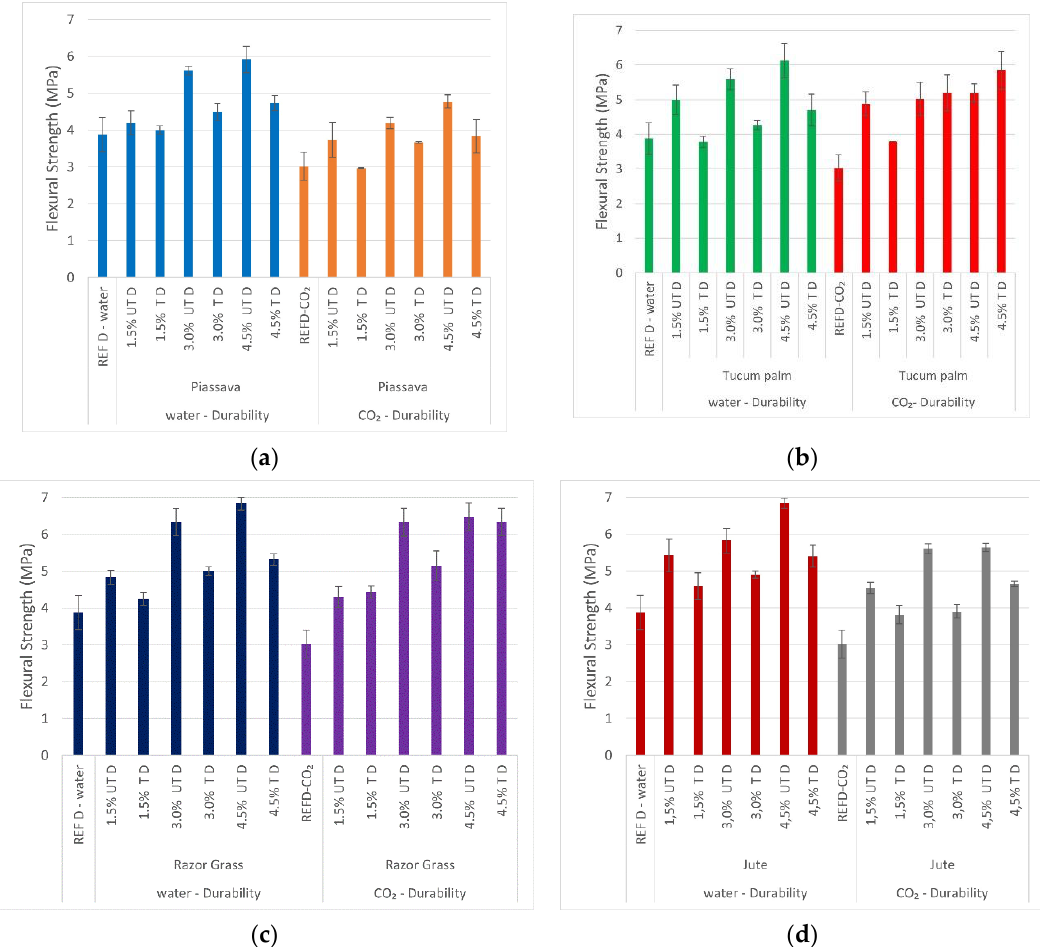
Figure 12. Durability cycles — flexural strength mortars: ( a ) 1.5%; 3.0%; 4.5% piassava mortars; ( b ) 1.5%; 3.0%; 4.5% tucum palm mortars; ( c ) 1.5%; 3.0%; 4.5% razor grass mortars; ( d ) 1.5%; 3.0%; 4.5% razor grass mortars; REFD — specimen without fiber after durability cycles; UTD — untreated fiber mortar after durability cycles; TD — treated fiber mortar after durability cycles; water and CO 2 — cured methods.